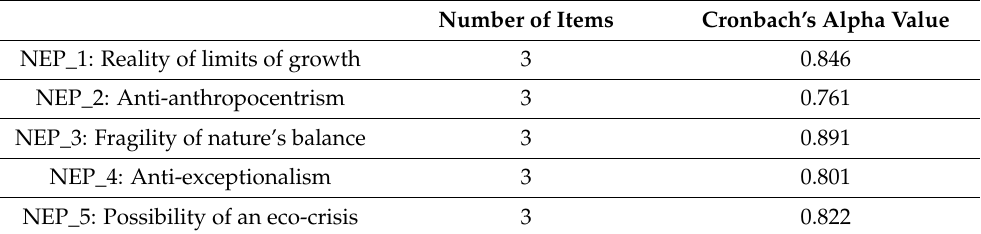
Table 1. NEP scale’s components’ Cronbach’s alpha values.